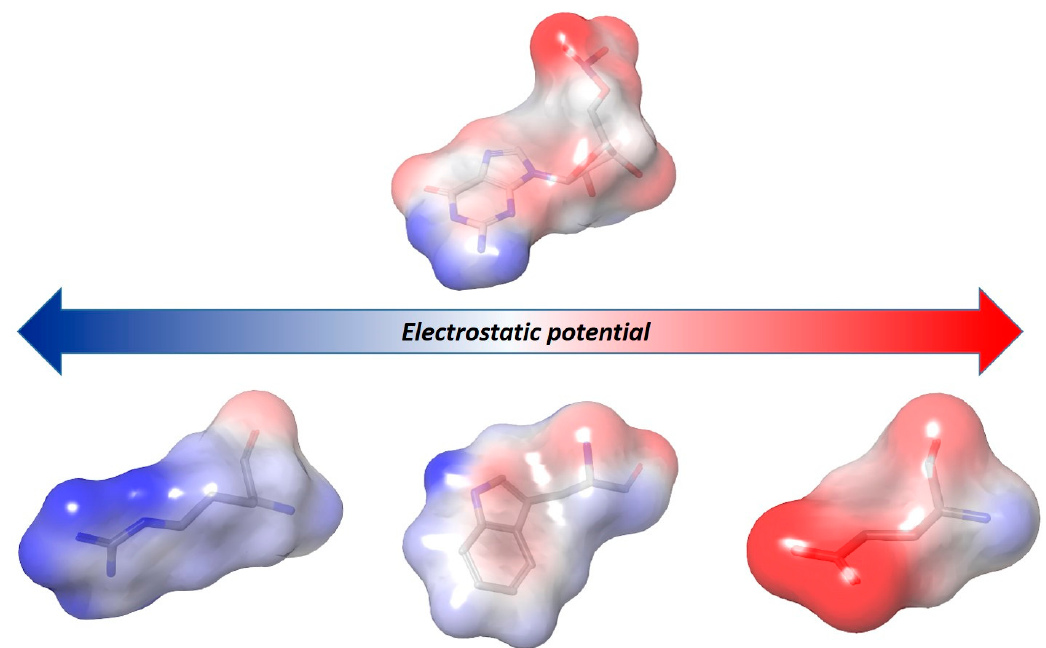
Figure 4. Comparison of the different charge distribution represented by electrostatic surface between polar amino acids (from left: arginine, tryptophan, and glutamate) and a nucleotide as guanosine monophosphate. The color ramp indicates in red the negative electrostatic potential energy values and in blue the positive values.